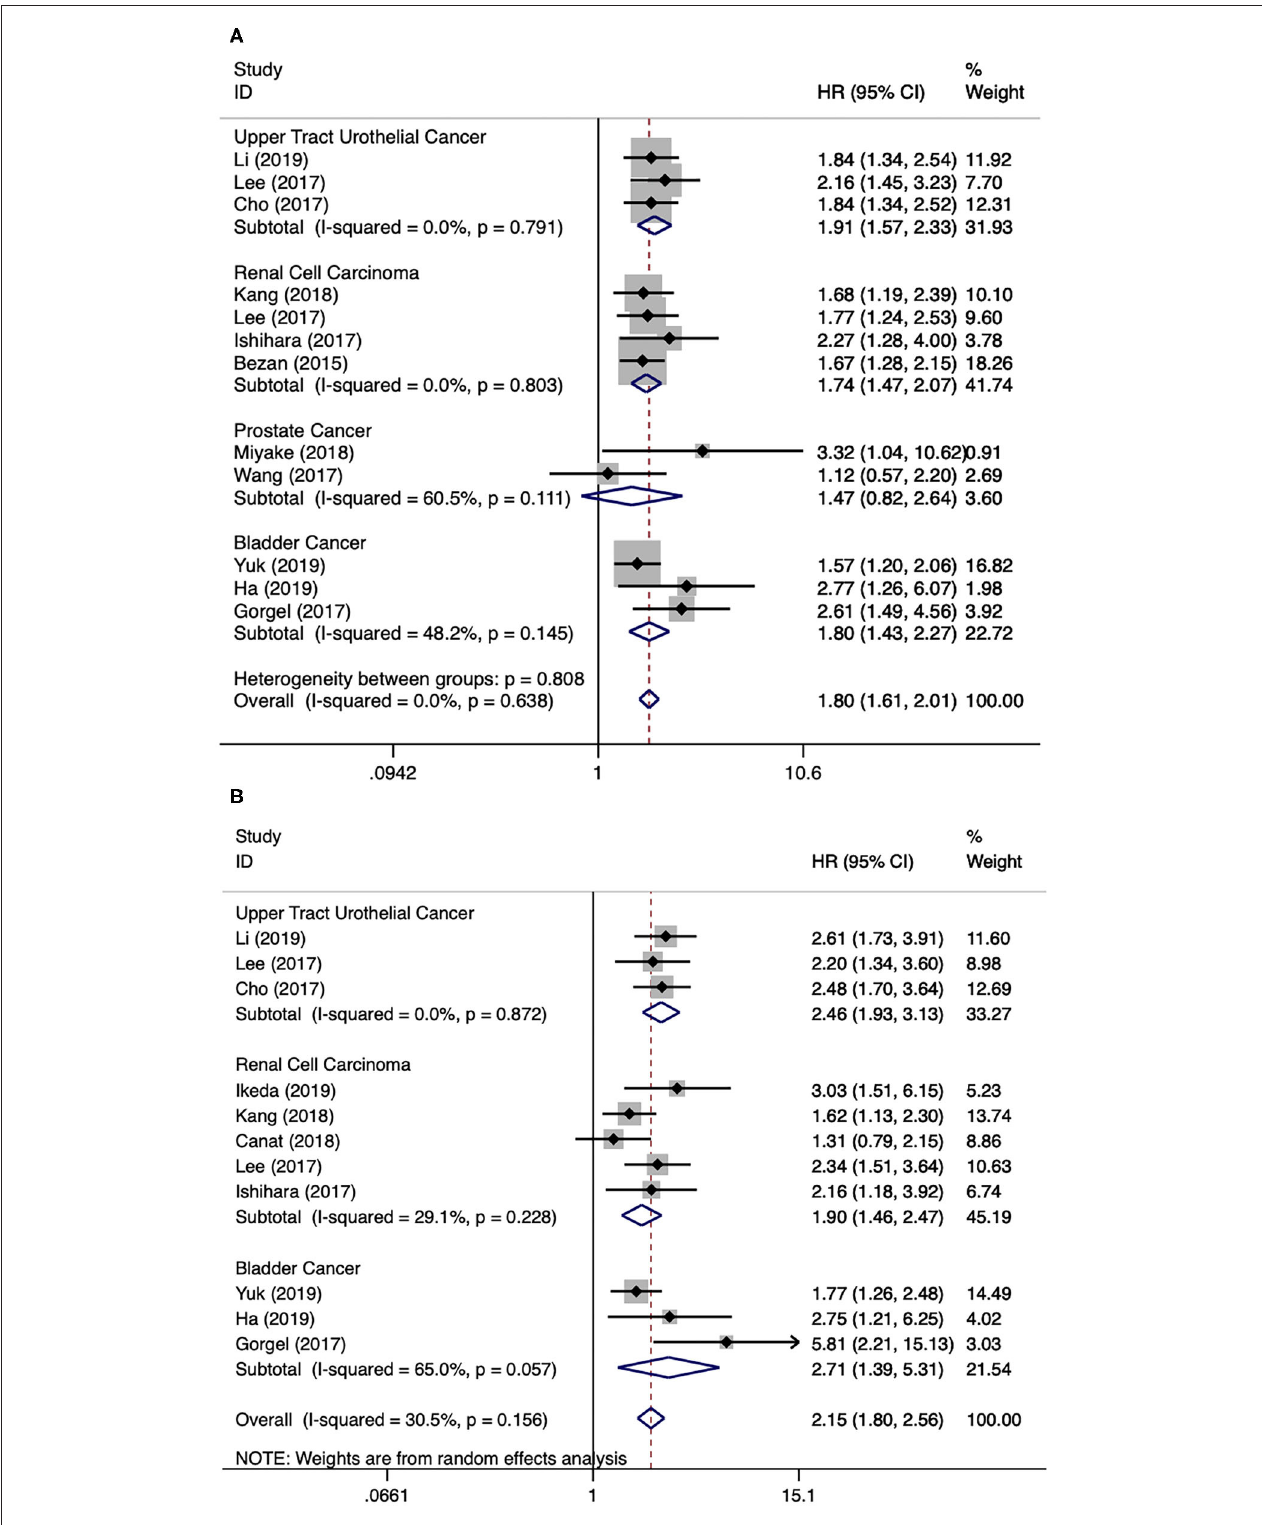
FIGURE 2 | Forest plot reflects the association between De Ritis ratio and OS/CSS for urological cancers. (A) De Ritis ratio and OS; (B) De Ritis ratio and CSS.